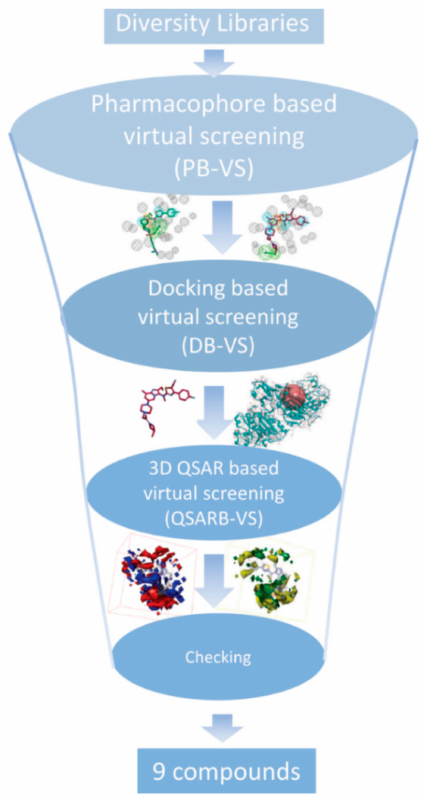
Figure 8. The workflow chart of the study. A combinatory virtual screening (VS) protocol based on the pharmacophore model, molecular docking study, and the 3D QSAR model was utilized to discover novel inhibitors targeting autotaxin.